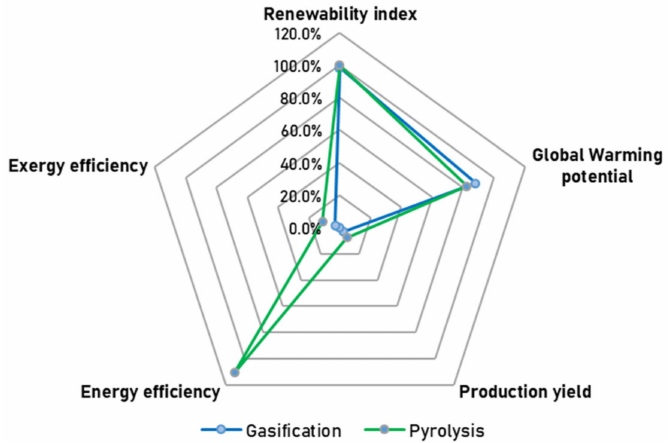
Figure 5. Radial chart of percent score for sustainability